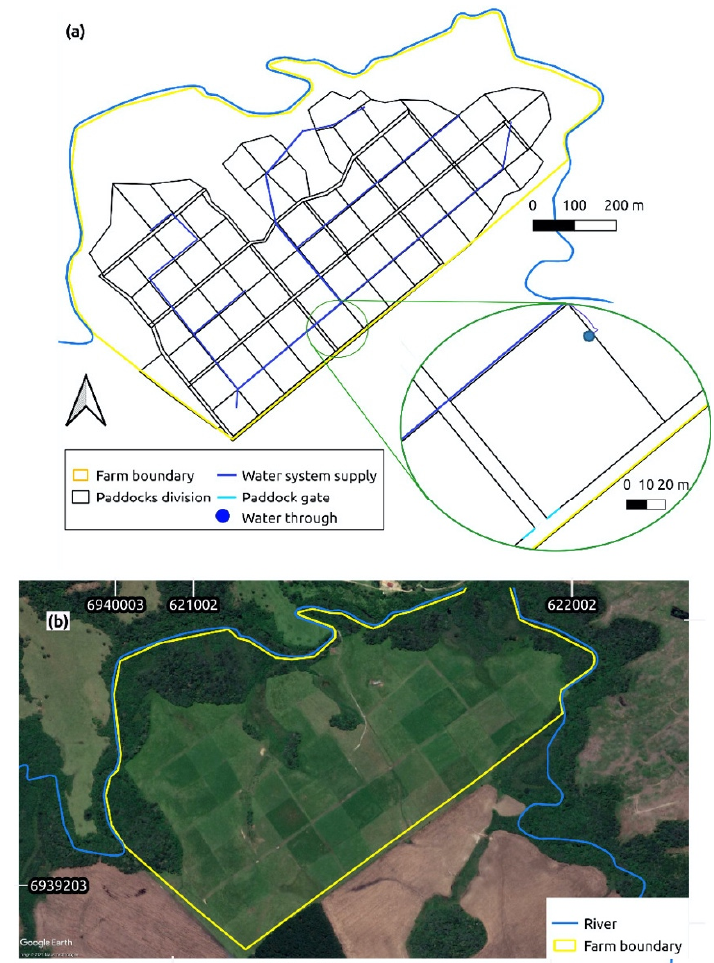
Figure 2. Eight-year-old commercial beef Voisin Rational Grazing (VRG) farm in Bom Retiro, Santa Catarina, Brazil. The total pasture area is 45 ha. ( a ) Blueprint of paddocks, alleyways (corridors) and hydraulic system. The total number of paddocks is 68. In VRG, water goes to the animals [12]; ( b ) satellite footage (Map Source—QGIS 3.16. (November 2018), Google Earth, Maxar Technologies, of the farm (accessed on 16 August 2021). The non-sequential use of paddocks creates what is called a “chess pattern”